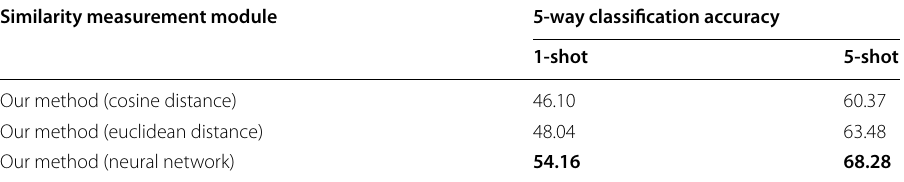
Table 7 Comparison of similarity measurement module in miniImageNet dataset (%) Similarity measurement